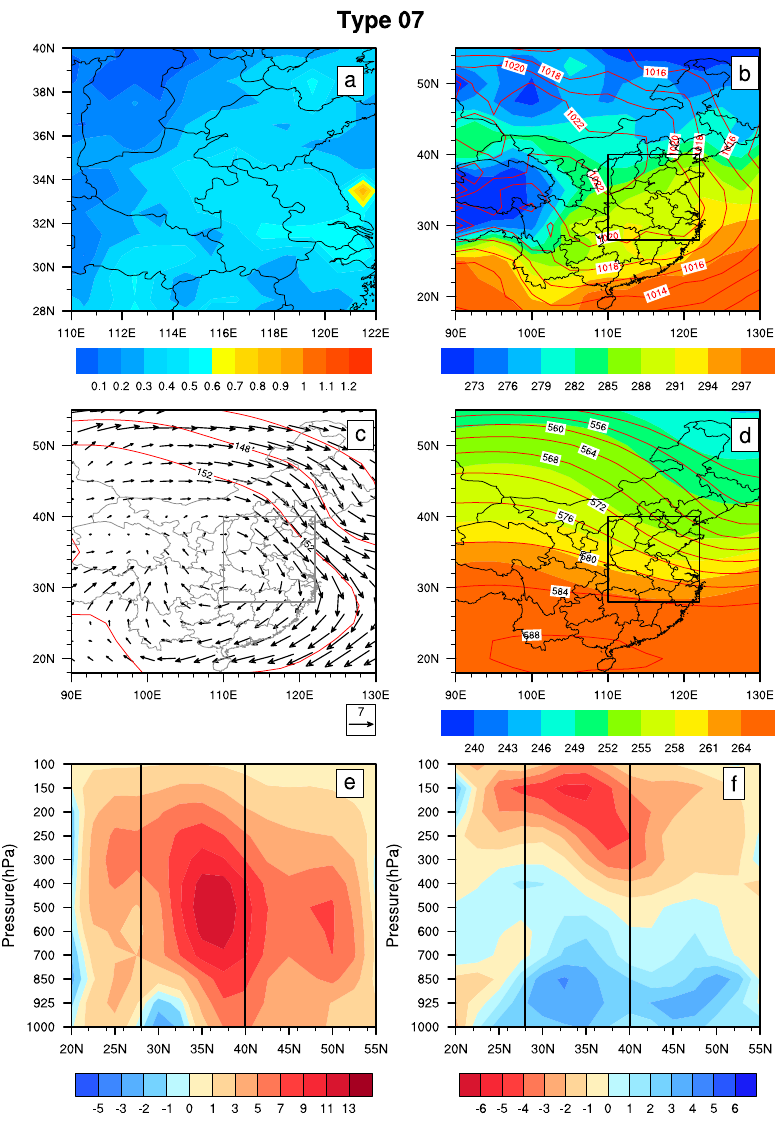
Figure 14. As in Fig. 8 but for Type 7